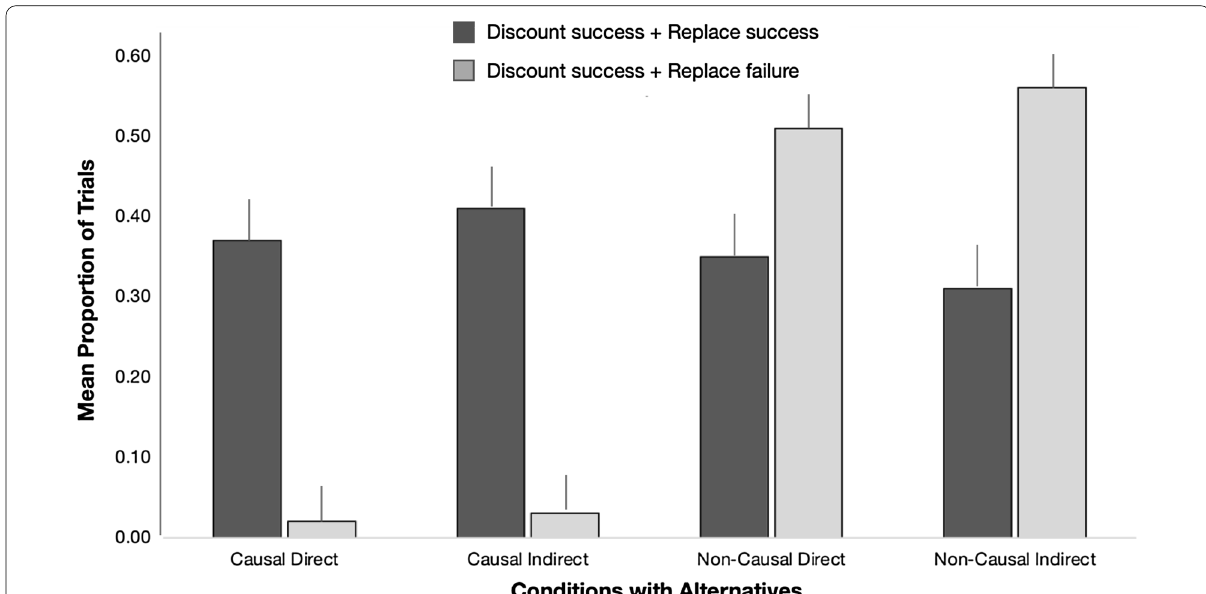
Fig. 8 Mean proportion of trials on which participants in different alternative conditions achieved full outdating (darker bars) versus only successful discounting (lighter bars). Error bars indicate standard error of the